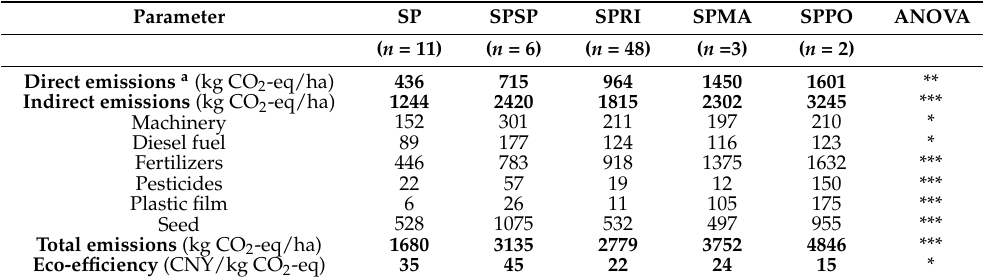
Table 5. GHG emissions of five sweet-potato-based cropping systems in Guangdong